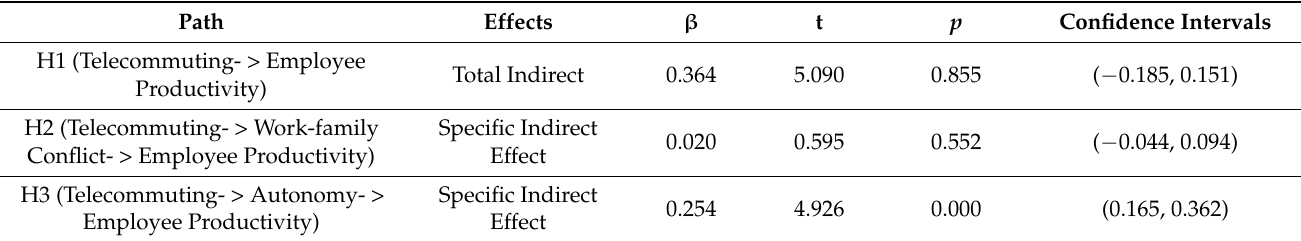
Table 4. Hypothesis Testing Direct and Specific Indirect